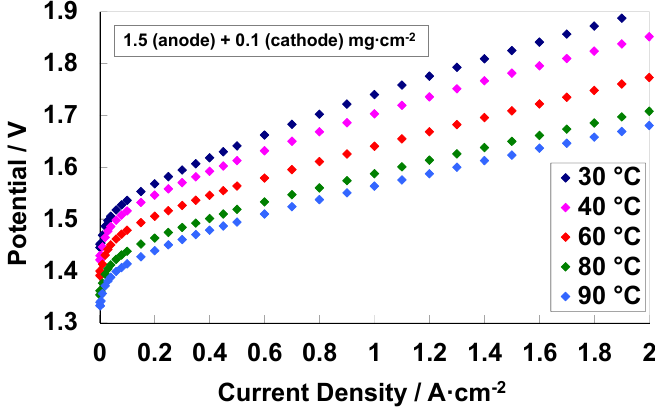
Figure 4. Polarization curves at different temperatures for the medium catalyst loading (1.6 mg cm − 2MEA )-based MEA.